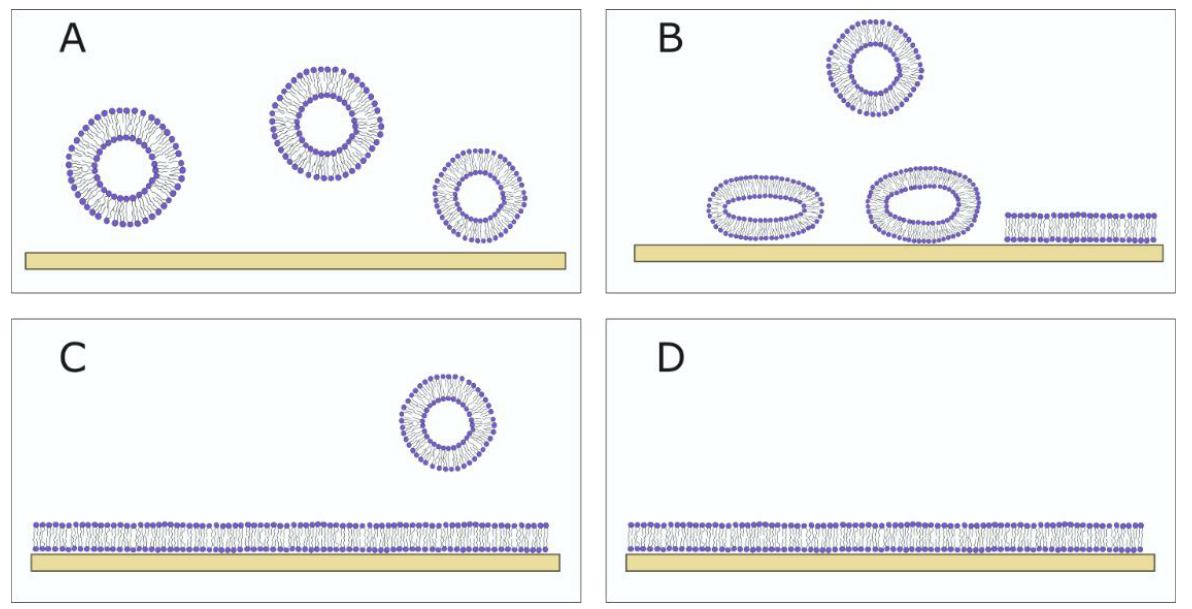
Figure 7. The SLB formation using vesicle fusion method. ( A ) Vesicles float in the bulk solution. ( B ) If the vesicle – substrate interaction is sufficiently strong, the adsorbed vesicles rupture on the sub- strate. ( C ) The SLB forms, and the unadsorbed vesicles are washed away using a buffer. ( D ) The fully formed SLB.